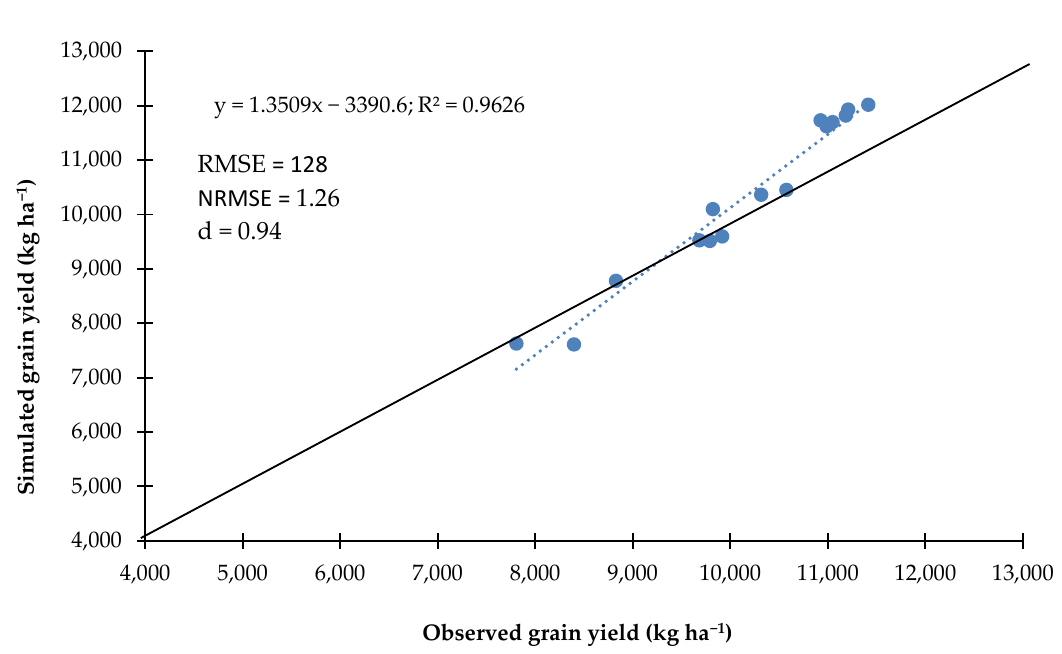
Figure 2. Calibration results of grain yield with their goodness of fit during the year 2015–2016.